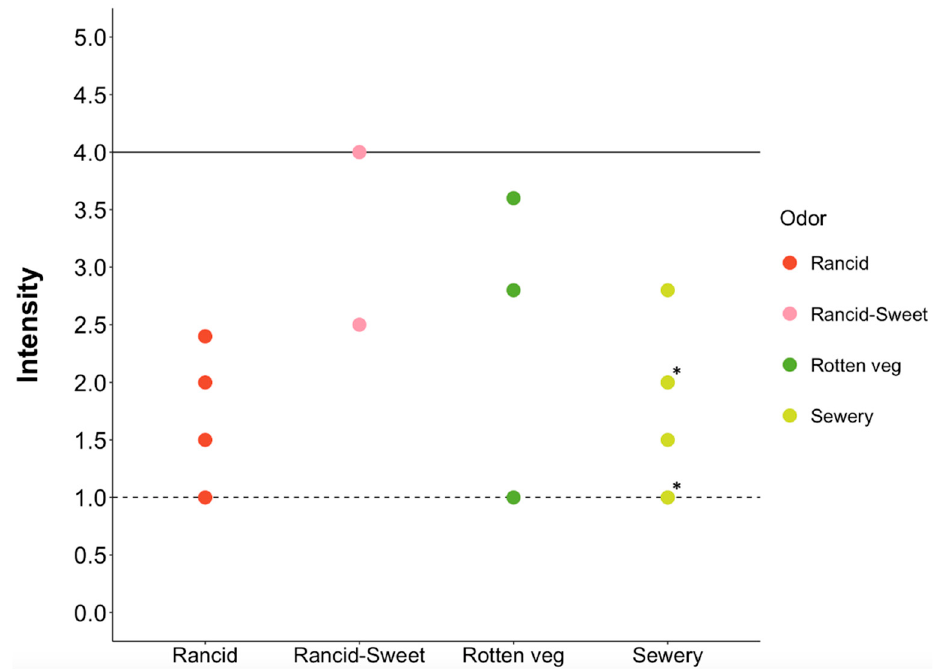
Figure 7. Average intensity and types of significant odors detected by the Odor Patrol. * Represents two results at the same intensity.